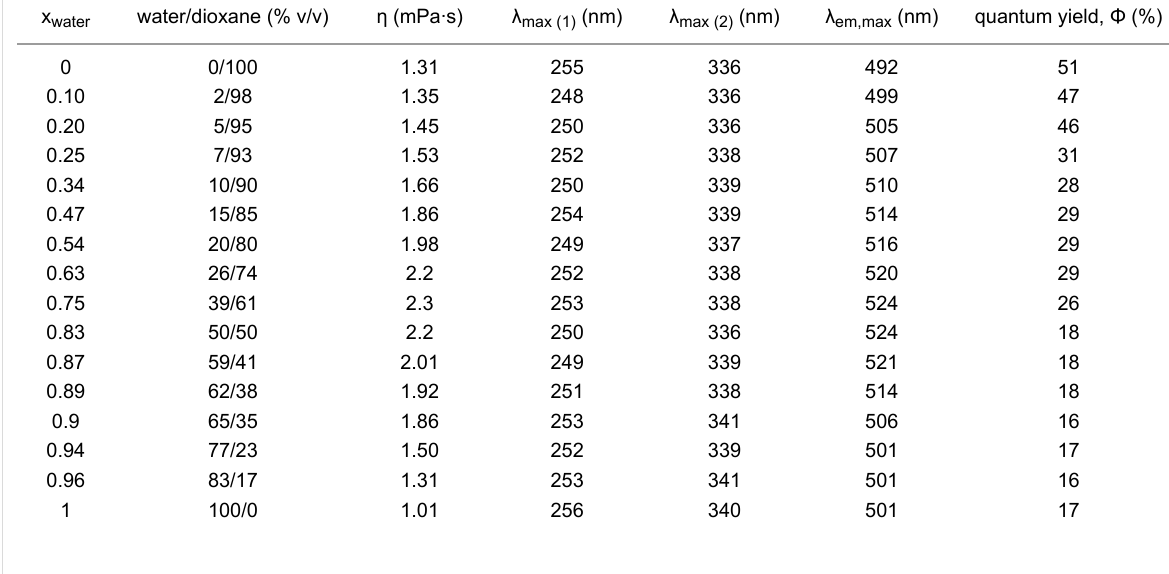
Table 2: Viscosity ( η ) [17], maximum of absorption ( λ max ), fluorescence emission (excitation wavelength 347 nm) ( λ em ), and quantum yield ( Φ ) (refer- ence: quinine sulfate) of compound 10 in mixtures of water/dioxane with different molar fractions (x) of water in 1,4-dioxane. x water